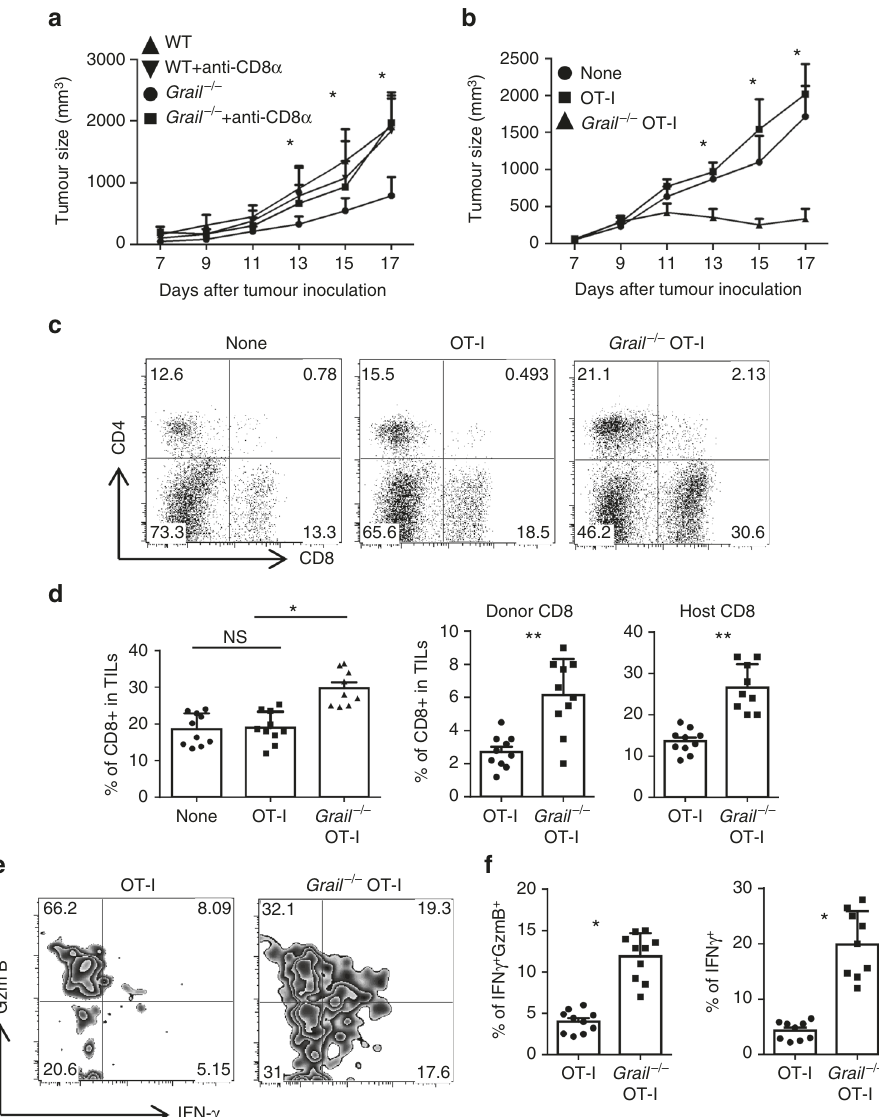
Fig. 2 Grail − / − CD8 + T cells are necessary and suf fi cient for tumour control. a WT and Grail − / − mice were injected with rIgG or anti-CD8 α antibody intraperitoneally 3 days before EG-7 tumour cell inoculation and weekly after that throughout the duration of the experiment. Tumour size was measured and calculated as in Fig. 1. ( n = 2 independent experiments with 5 – 7 mice per group) b – e CD45.1 + congenic mice were inoculated with EG-7 tumours and on day 5 (when tumours are palpable), were injected i.v. with puri fi ed CD45.2 + OT-I or Grail − / − OT-I cells. A group of mice that did not receive OT-I cells was used as control (None). b Tumour size in all recipient mice was calculated as in Fig. 1. ( n = a total of 10 mice per group from two experiments). c , d The percentage of total CD8 + T cells and CD4 + T cells in TILs were analysed. A representative dot plot is shown in c . d The percentage of CD8 + TIL from each group is shown from individual mice on the left bar graph . The middle bar graph shows the percentage of donor CD45.2 + CD8 + TIL and the right bar graph shows the percentage of host CD45.1 + CD8 + TIL from each mouse ( n = 10 mice per group from two experiments). e , f TILs were stimulated for 5 h with OVA peptide and the production of IFN- γ and granzyme B (GzmB) was analysed in the CD45.2 + CD8 + gate by intracellular staining. A representative zebra plot is shown in e . f The bar graph shows the percentage of IFN γ + GzmB + and IFN γ + subsets per mouse ( n = 10 mice per group from two experiments). d , f Results are shown as mean ± SEM. * p < 0.05, ** p < 0.01, NS as determined using a Student ’ s t -test. NS not signi fi IFN γ responses. As we did not detect any IFN γ single producing cells, we focused on the granzyme B + IFN γ + subset. − / − To con fi rm the functional state of Grail CD8 + T cells in the